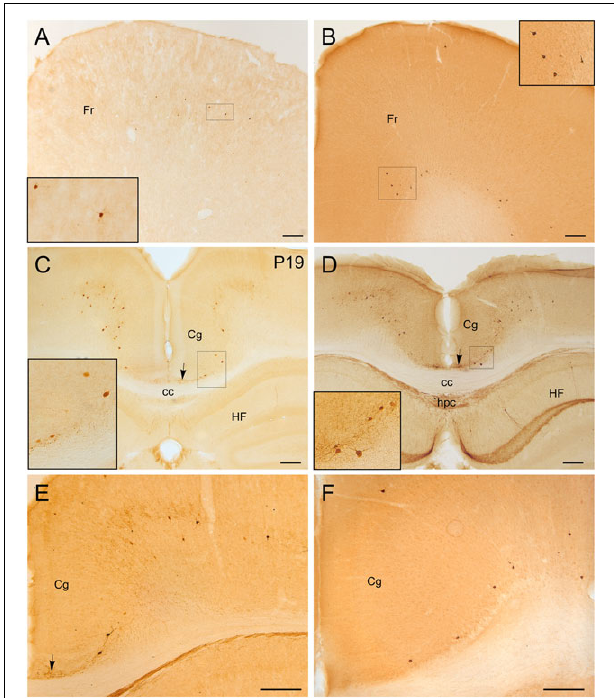
FIGURE 6 | GFP and HA immunoreactivity in the cerebral cortex, including the cingulate cortex. Images of frontal brain sections of adult Otp-eGFP mice (A,C–E) and Otp-Cre; Rpl22-HA mice (B,F) , showing GFP or HA immunoreactive cells in the mesocortex and neocortex, including frontal (A,B) and cingulate areas (C–F) (details of cells in insets). A fascicle of labeled fibers is seen in the cingulate bundle [arrows in panels (C–E) ] in the Otp-eGFP mice, and a group of cells appear in the vicinity of it in the cingular cortex [insets in panels (C,D) ]. In the Otp-Cre; Rpl22-HA, labeled cells are observed in similar positions of the mesocortex and neocortex to those in the Otp-eGFP, but many of them occupy a deeper stratum than those in the Otp-eGFP. See text and abbreviation list for more details. Scale bar: panels (A–F) = 200 µ